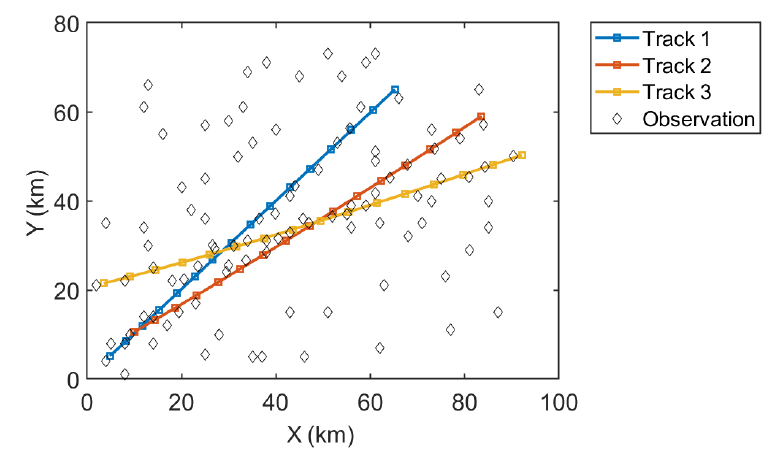
Figure 11. The tracking results of the MHT-EnKF for three targets.